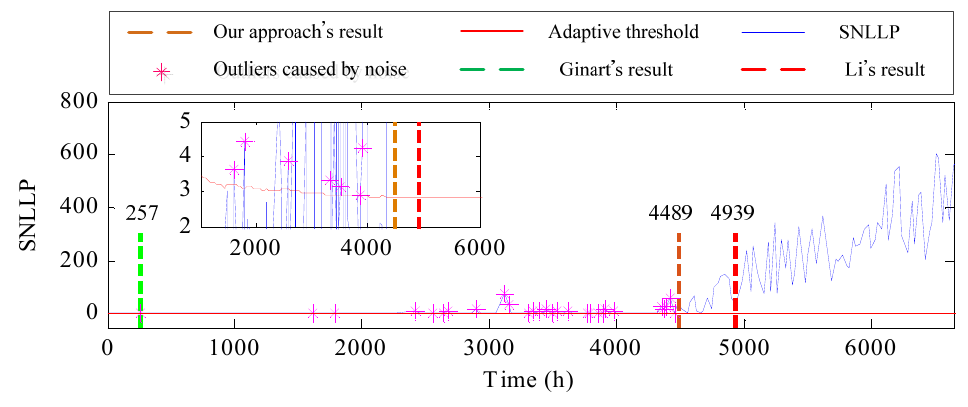
Figure 12. The detection result of WT incipient fault.